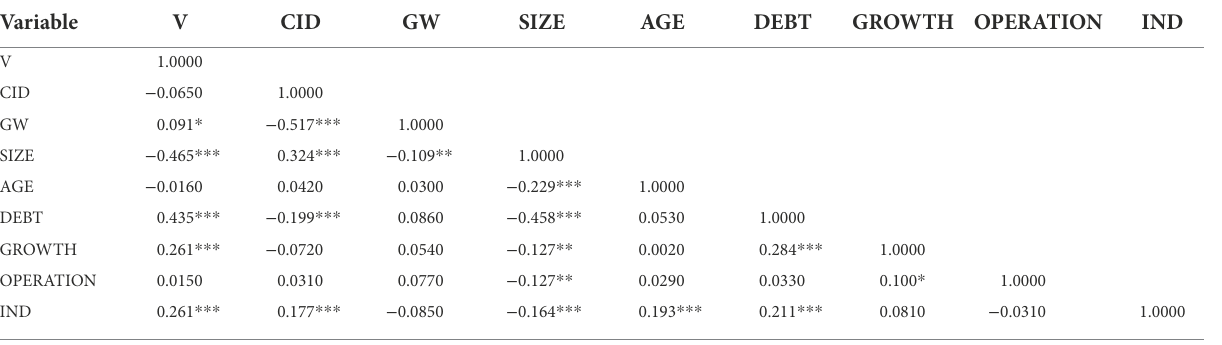
TABLE 10 Correlation analysis.